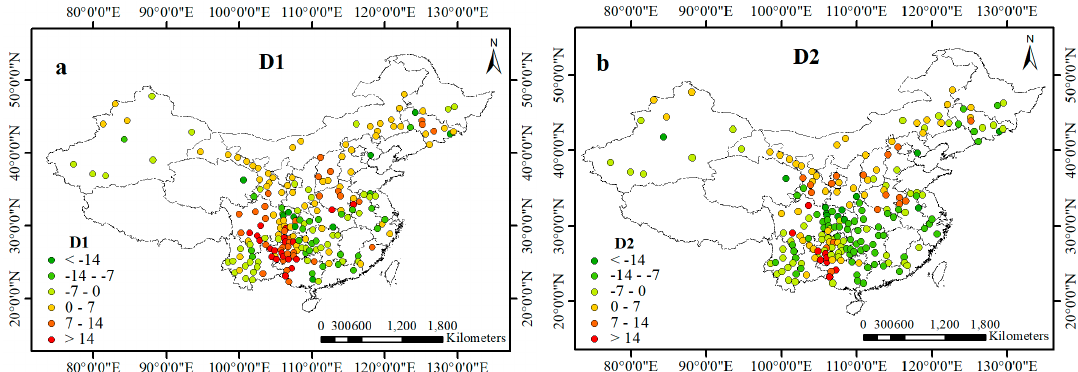
Figure 11. Difference between ( a ) all drought events and ( b ) severe and extreme drought events between the SWDI-SMAP and AWD at 204 monitoring stations with both SM and climate data. 30 pairs of 7-day averaged data were used from 1 April 2016 to 30 September 2016.